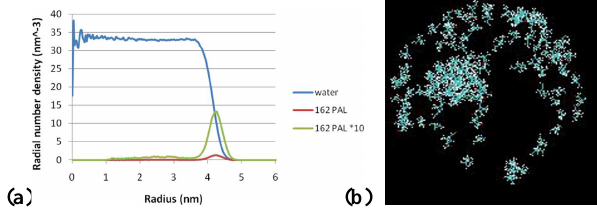
Fig. 3a. 162 PAL molecules aggregate near the surface leading to a large peak for radial number density at 4.2 nm. The green line is the radial number density of the PAL molecules multiplied with a factor of 10.